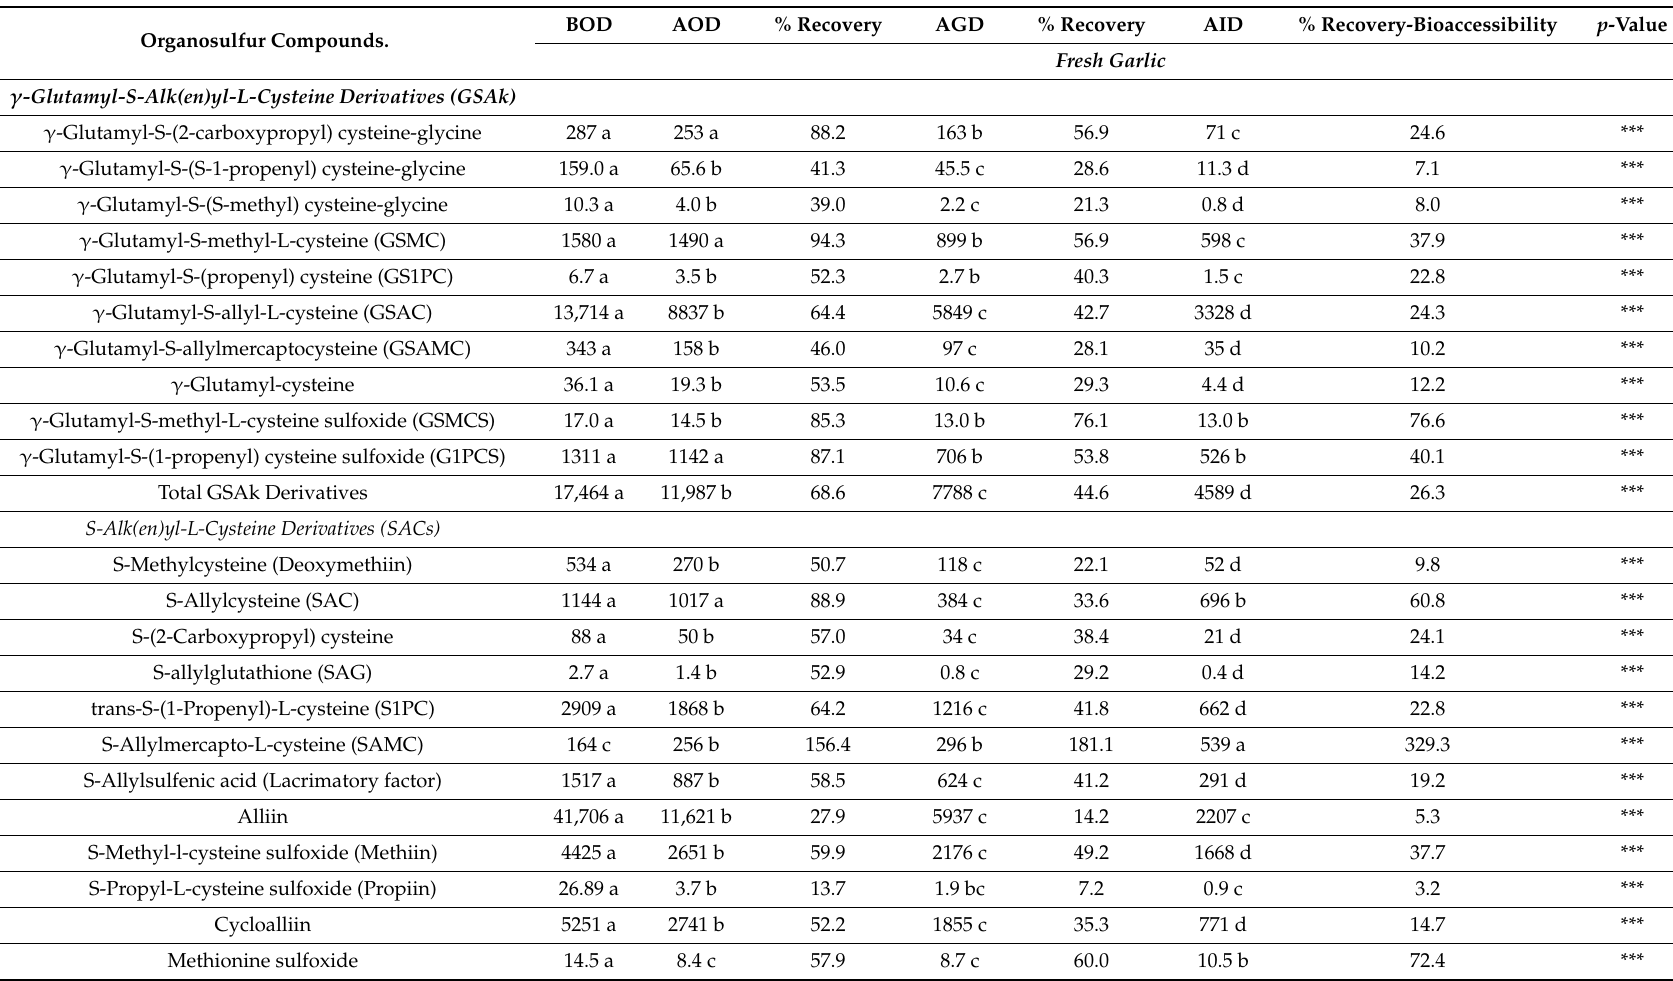
Table 2. Concentration (nmol / g FW) of organosulfur compounds presented in fresh and black garlic samples at di ff erent stages during the simulated gastrointestinal digestion. Data are expressed as mean values ( n = 6). Organosulfur